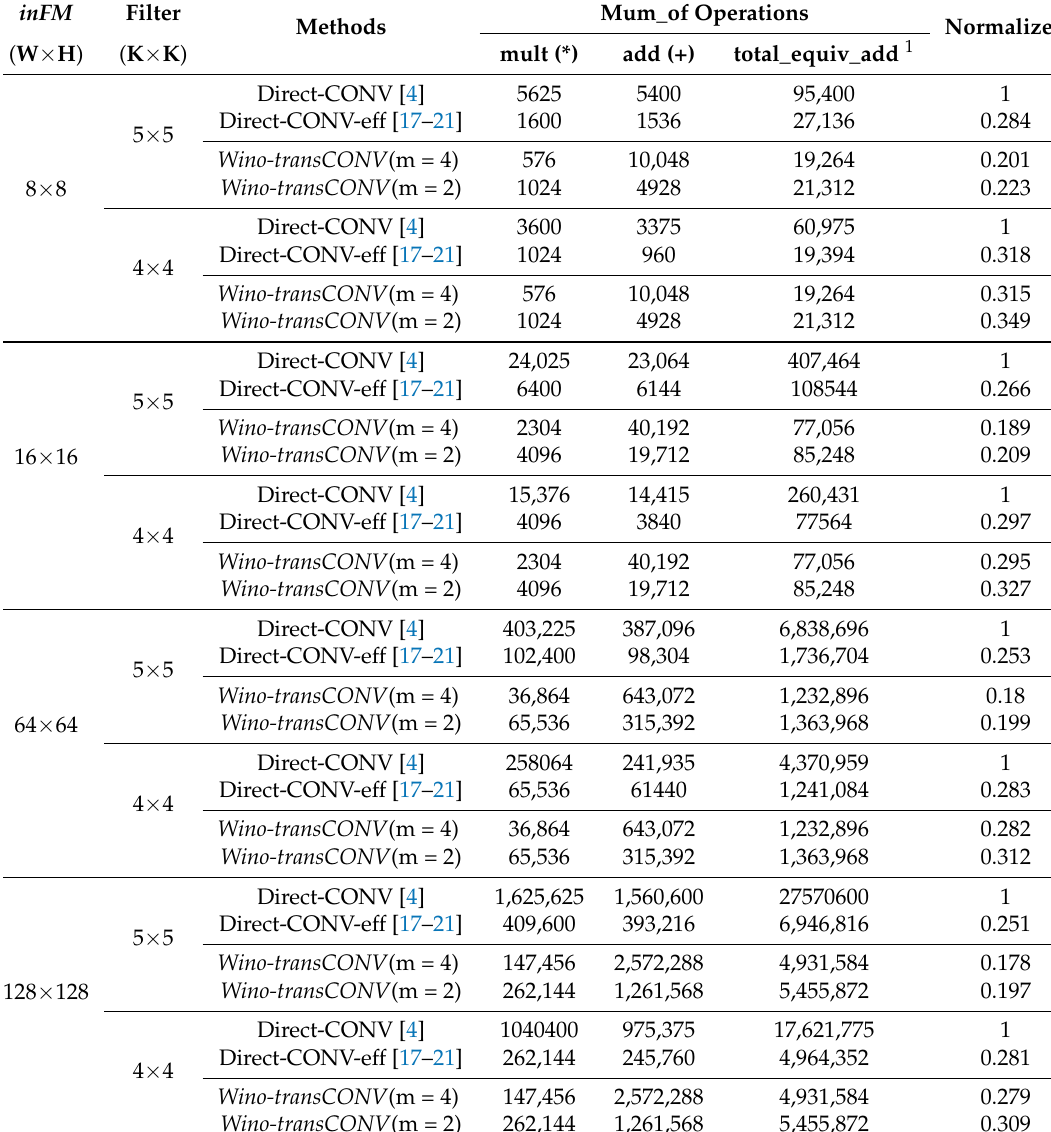
Table 1. Computational resource usage